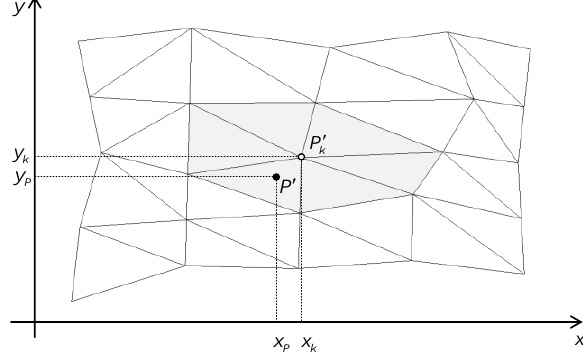
Figure 8. Searched triangles (marked in grey).